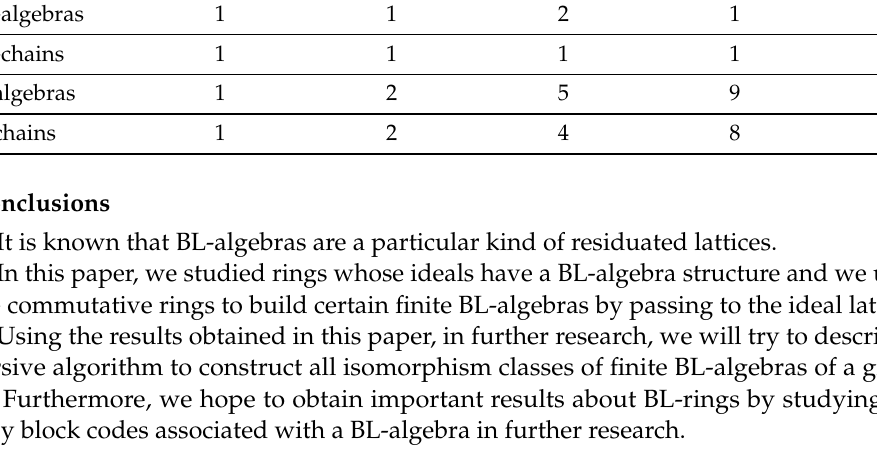
Table 3. A summary of the number of the obtained BL-algebras. n =